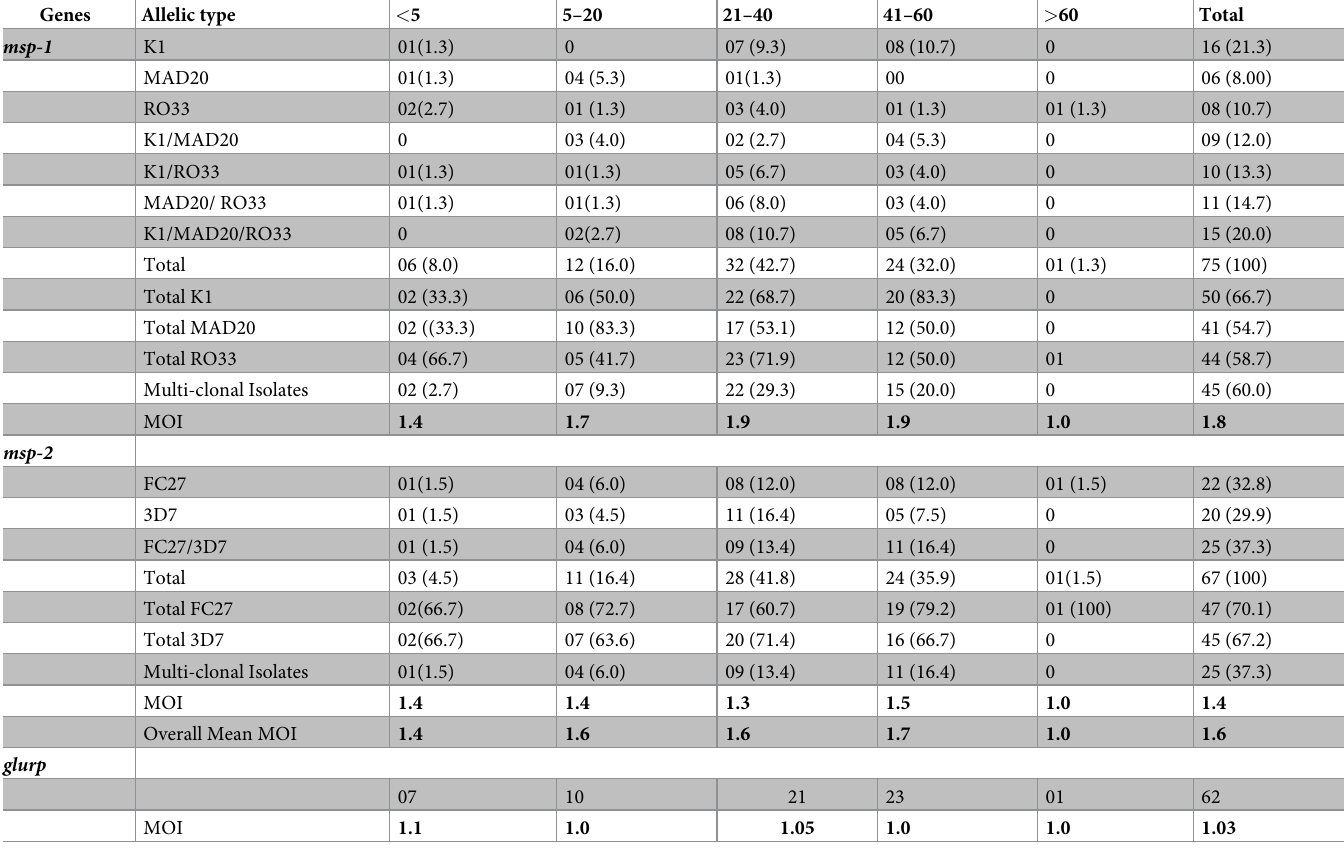
Table 5. Distribution of msp-1 , msp-2 and glurp allelic types among different age groups of P . falciparum infected patients from KP,